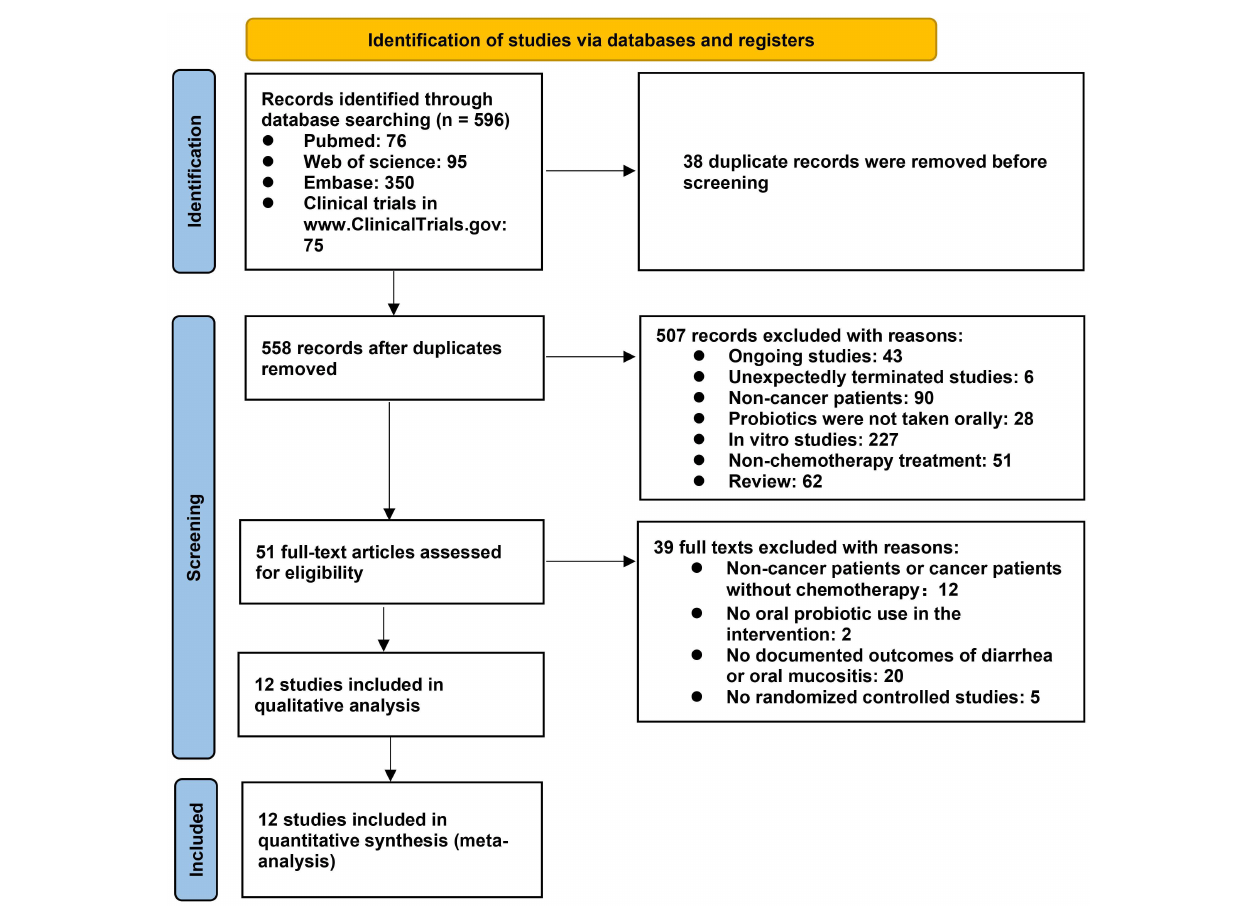
FIGURE 1 | Study flow